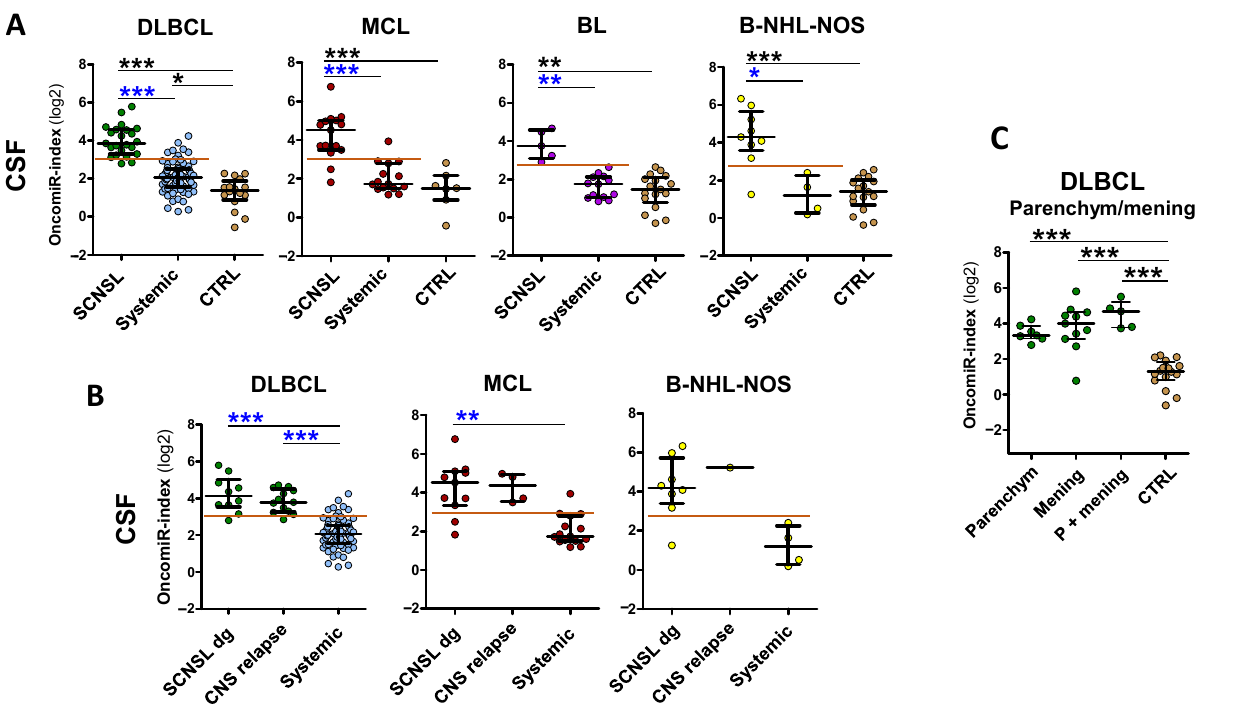
Figure 1. OncomiR indices are increased in cerebrospinal fluid of CNS-involving lymphomas. OncomiR indices (logistic regression model) combining expression of oncogenic microRNAs (oncomiRs, miR-21/-19a/-20a/-92a/-155 as in Table 1) into single classifier in cerebrospinal fluid (CSF) of lymphoma patients with indicated B-NHL diagnoses. ( A ) Lymphoma patients with secondary CNS involvement (SCNSL), compared to systemic lymphoma patients and control patients (CTRL). ( B ) SCNSL lymphomas are subdivided into lymphoma with secondary CNS involvement presented at the time of diagnosis (SCNSL dg) and newly detected CNS relapses. ( C ) OncomiR indices in CSF of DLBCL stratified according to parenchymal, meningeal, and combined parenchymal and meningeal (P+mening) CNS involvement (all BL-SCNSL are from dg). qRT-PCR. The red line indicates the threshold for positive CNS lymphoma involvement. Log2 scale. Median ± interquartile range, Table 1. Predictive accuracy of oncomiR indices to detect CNS lymphoma involvement. CSF oncomiR Index p Value AUC Sensitivity